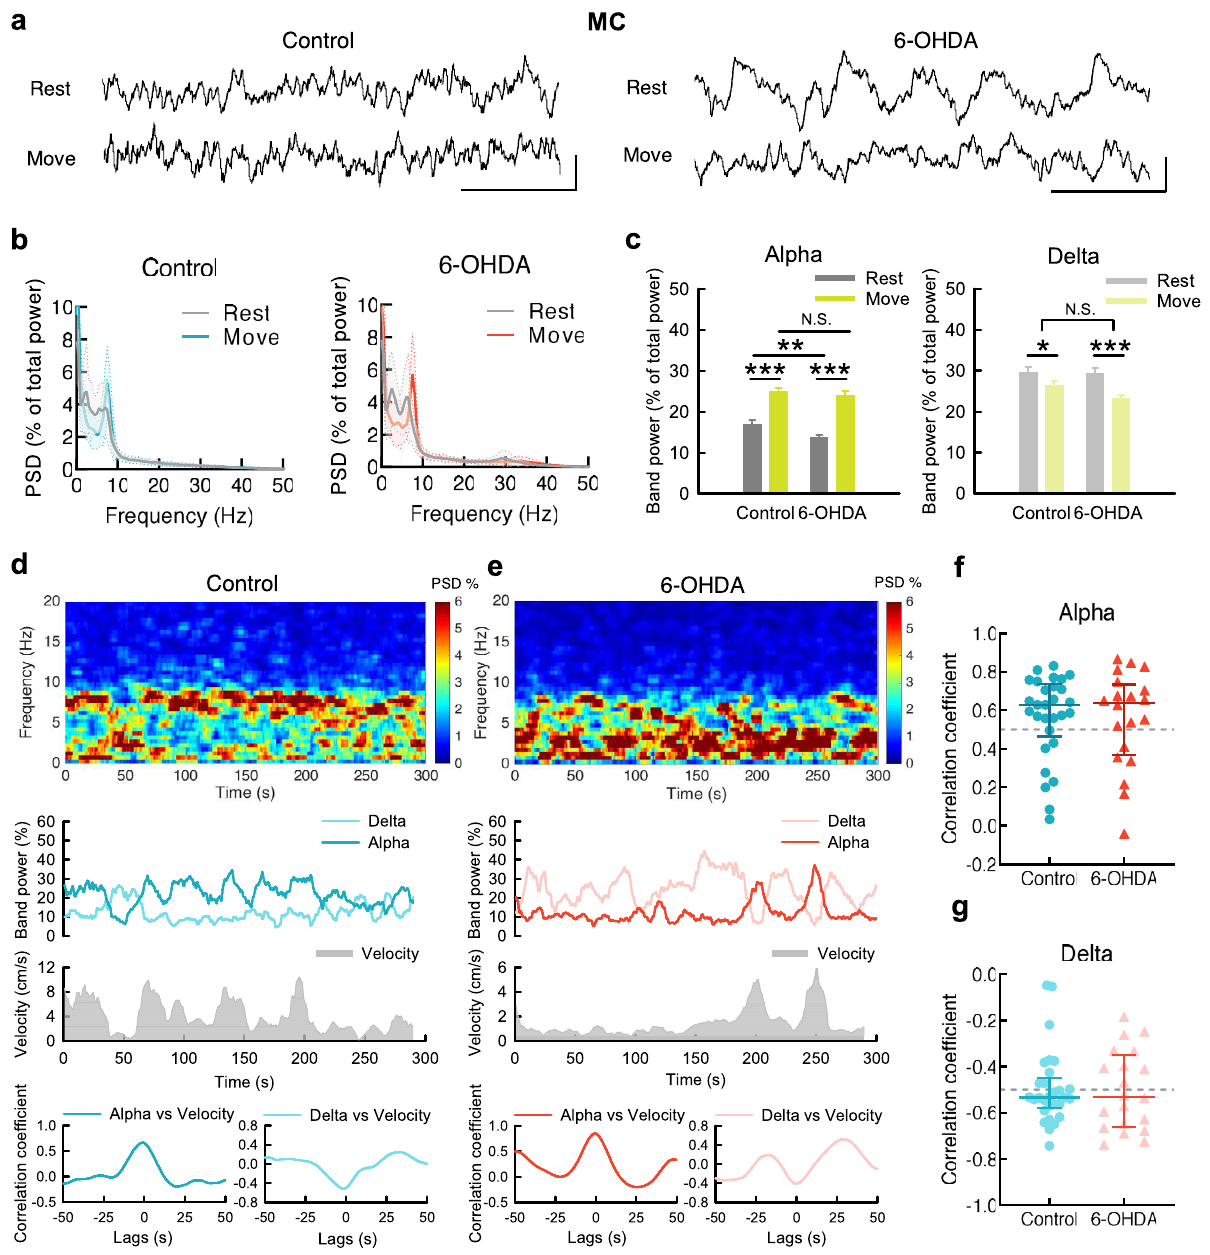
Fig. 2 The changes of MC rhythms upon movement in control and parkinsonian rats. a Sample MC LFP recordings during rest and movement from a control rat (left) and a parkinsonian rat (6-OHDA, right). Scale bar represents 500 ms/100 μ V. b Average PSD spectra in MC during 10-s continuous rest or movement show a marked increase of α power and decrease of δ power from rest to movement in both control and parkinsonian rats ( n = 52 and 50 matched segments of rest and movement from 10 control and 11 parkinsonian rats, respectively). c Band power analysis from part b . d , e Power spectrograms (top) and the temporal changes of MC α and δ band powers (middle, upper) as well as concomitant moving velocities (middle, lower) from a sample 5-min recording in OFT in control ( d ) and in parkinsonian rats ( e ). Cross- covariance analysis between time-varying band power and moving velocity reveals an evident peak of correlation coef fi cient at zero time lag in α band (bottom, left), but a valley in δ band (bottom, right) in control and parkinsonian rats. Each series of data contain one data point per second (300 data points in total). f Cross-covariance analysis from all 5-min recordings shows that most of control and parkinsonian rats have a strong correlation coef fi cient (>0.5) between MC α power and moving velocity at zero time lags. Correlation coef fi cient >0.5: control = 21/29 (72%), parkinsonian = 14/20 (70%); median of correlation coef fi cient, control: 0.63, parkinsonian: 0.64. g Similar analysis to that in ( f ) shows no positive but negative correlation between δ power and moving velocity. Correlation coef fi cient < − 0.5: control = 19/29 (66%), parkinsonian = 11/20 (55%); median of correlation coef fi cient, control: − 0.53, parkinsonian: − 0.53). PSD spectra were presented as mean (solid curves) ± standard deviation (shaded areas). Data in bar plot were presented as mean ± S.E.M. Data in ( c ) were analyzed with 2 × 2 mixed model ANOVA and simple main effect tests for pairwise comparison. Each horizontal line reports the simple main effect, and the square bracket reports the main effect of control vs. 6-OHDA in ANOVA. * p < 0.05, ** p < 0.01, *** p < 0.001, N.S., nonsigni fi cant.